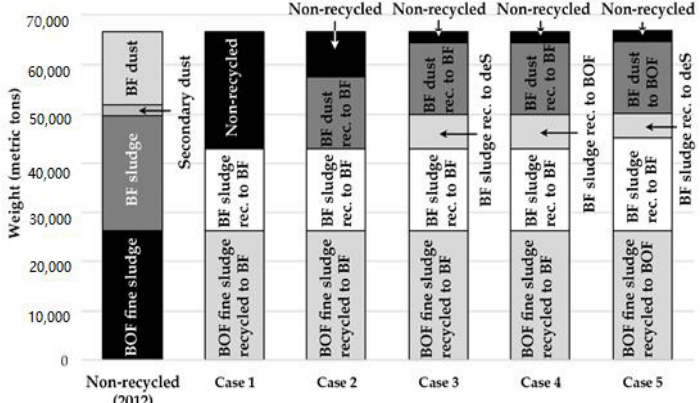
Figure 1. Annual generation of residues not recycled as of 2012, as well as recycling considered in cases 1 through 5. All weights are given in dry weights.